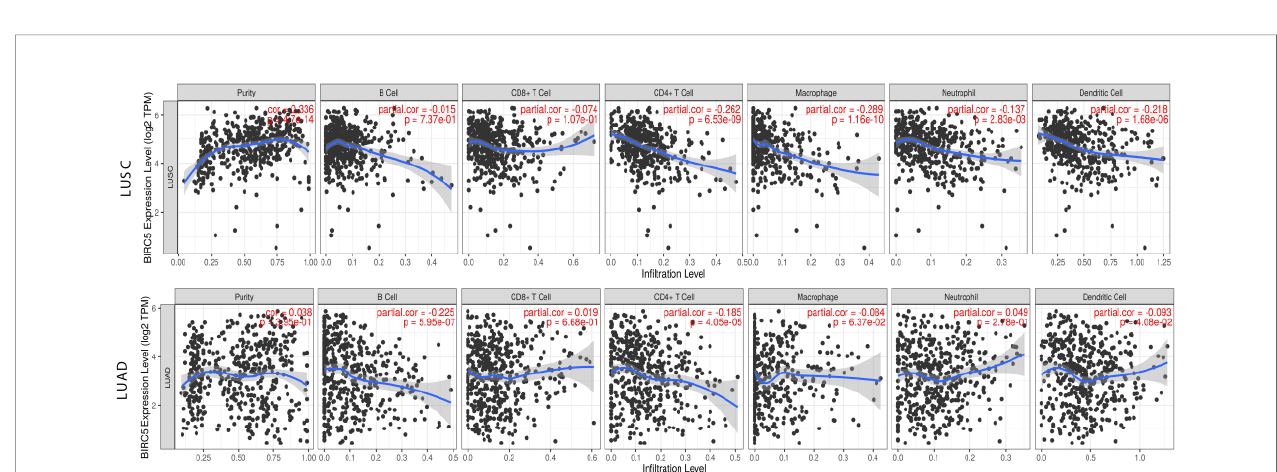
FIGURE 7 | Survival analysis FP, OS and PPS of BIRC5 in LUSC and LUAD patients obtained from KM plotter.